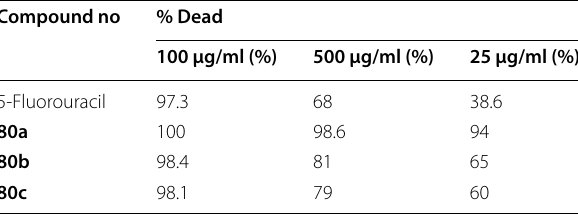
SEM of three independent ±